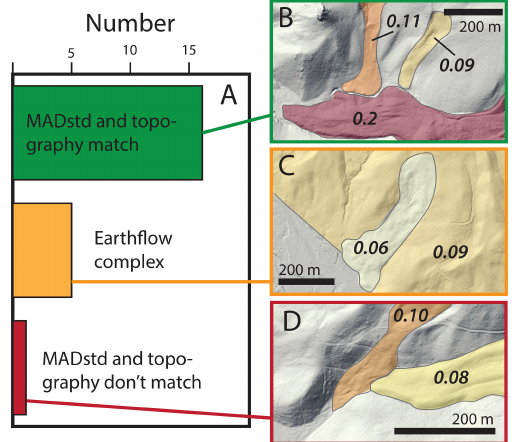
Figure 7. (a) Cross-cutting relationships compared with MADstd relative age relationships and (b–d) examples of cross-cutting re- lationships underlain by a lidar hillshade (Quantum Spatial, 2015, 2018). (b) Two examples where the higher MADstd earthflow to- pographically truncates two lower MADstd earthflows. (c) An ex- ample where the MADstd relative dating does not work, in which the cross-cutting earthflow has a lower MADstd than the earthflow complex it sits within. (d) An example where the toe of a lower MADstd earthflow onlaps a higher MADstd earthflow, indicating a mismatch between MADstd and topography. Numbers indicate the MADstd value for each earthflow, which is also reflected by the earthflow color, using the same color scheme as Fig. 2.